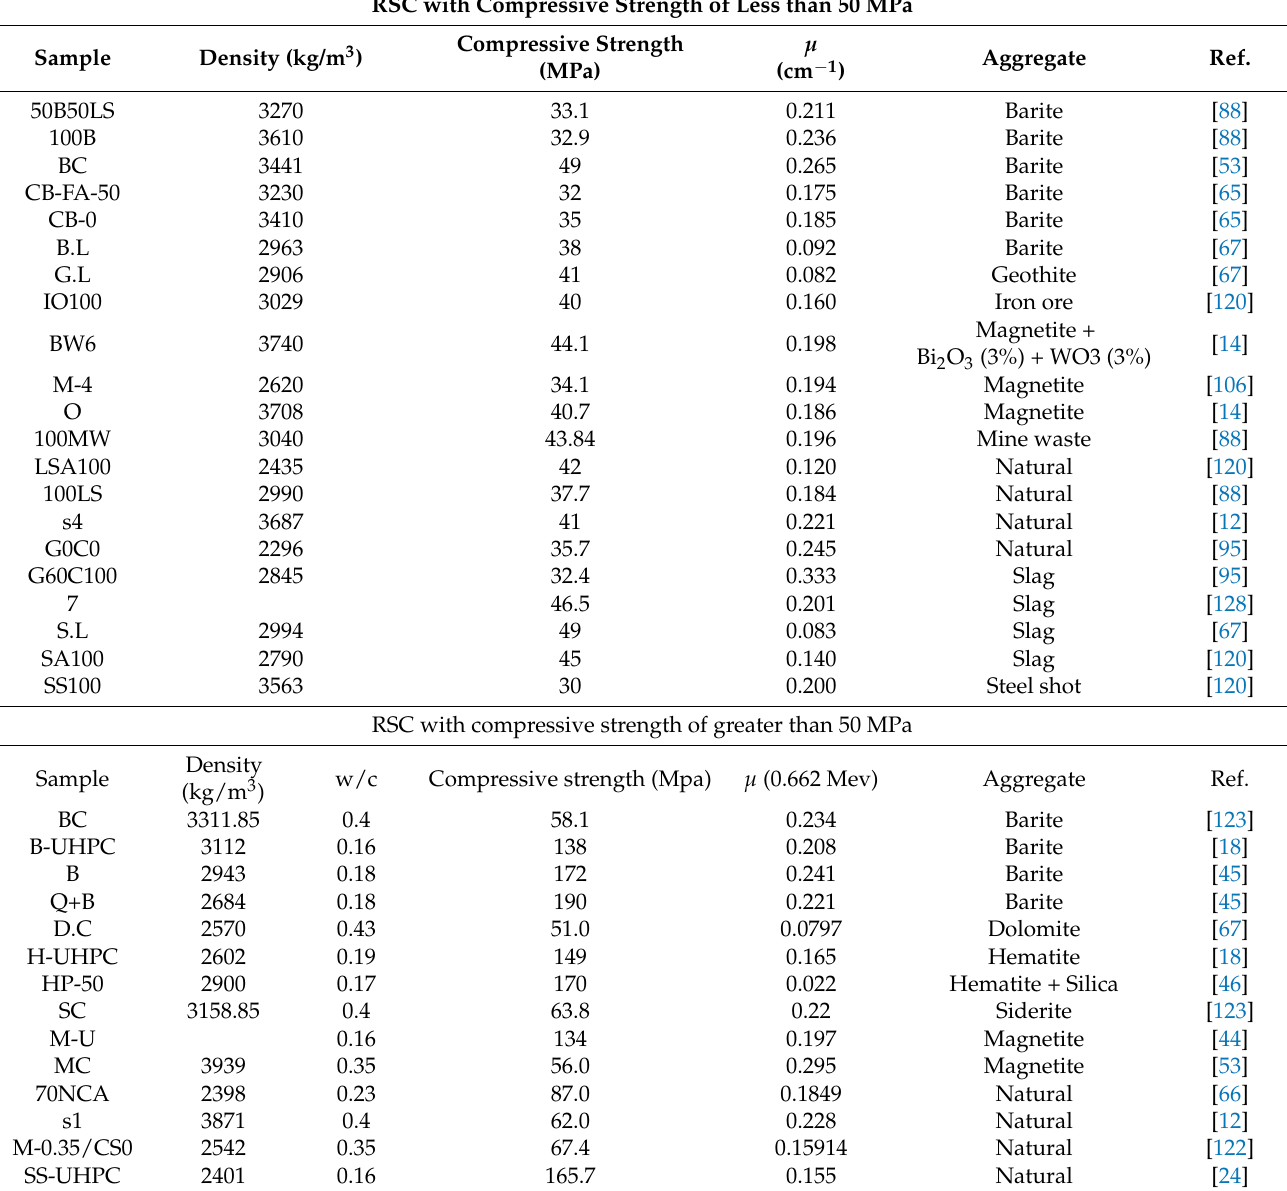
Table 5. Compressive strength of